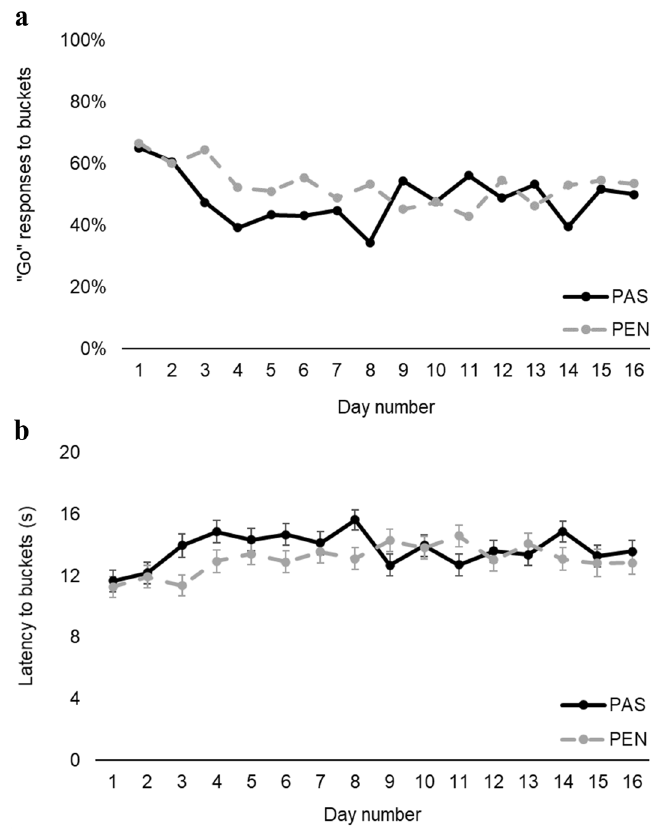
Figure 5. ( a ) Percentage of “Go” responses and ( b ) response latency to all buckets in each treatment (pasture access: PAS; cubicle housing: PEN) throughout the experiment (days 1–16). Error bars represent standard error of the